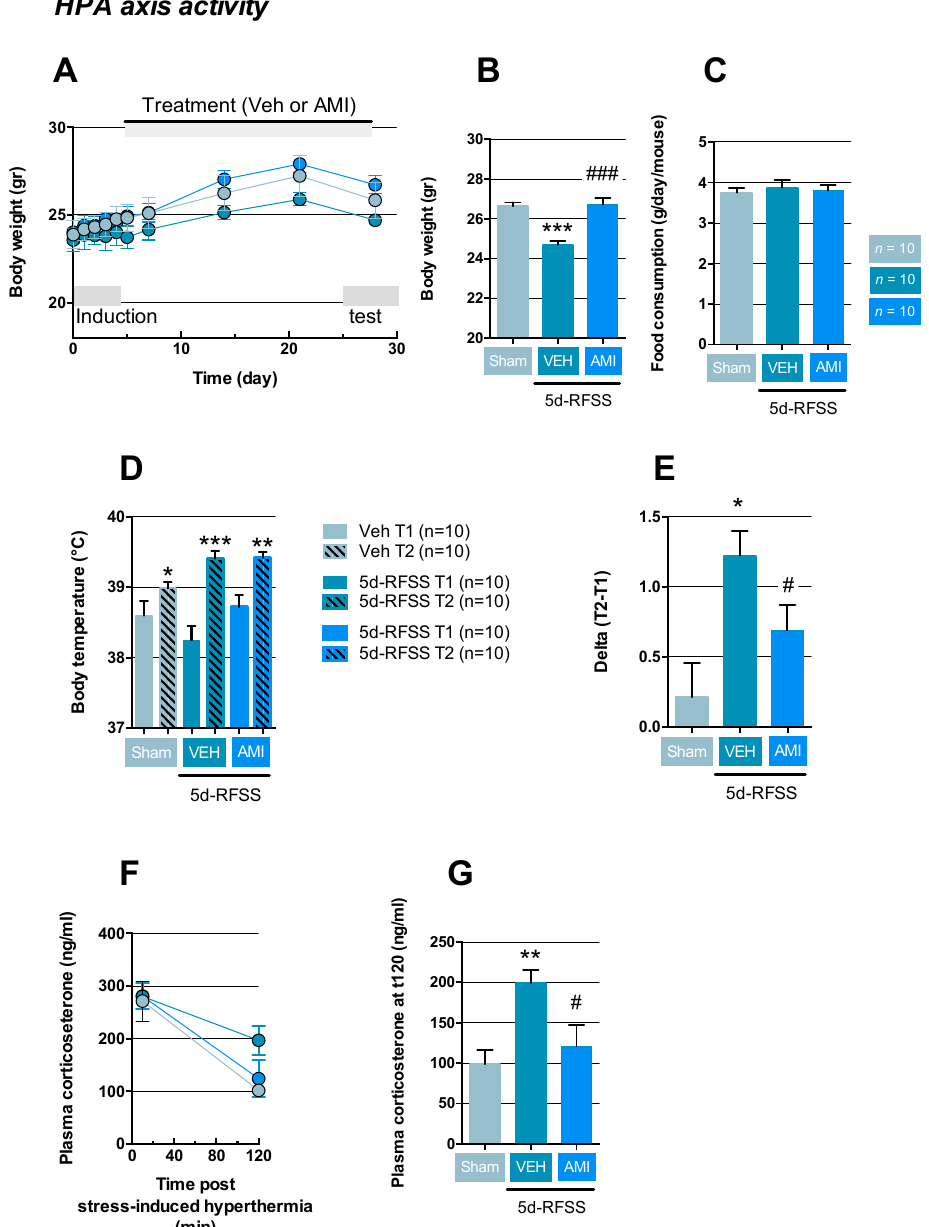
Figure 3. Impact of 5d-RFSS on HPA axis in C57BL/6J mice. ( A – C ) Body weight and food consumption. Data are means ± SEM of body weight (in g). Kinetic ( A , B ) body weight measured just before the test phase. One-way ANOVA showed a significant effect of treatment factor (F(2,27) = 20.6; p < 0.001). Data are means ± SEM of food consumption (C). One-way ANOVA did not show a significant effect of treatment factor (F(2,27) = 0.17; p = 0,83]. ( D , E ) Stress-induced hyperthermia. Data are means ± SEM of body temperature (in degrees Celsius) after the first (T1) and second (T2) measure ( D ). Two-way ANOVA with repeated measures did not show a significant effect of treatment (F(2,25) = 1.65; p = 0.21) but a significant effect of time (F(1,25) = 48.37; p = 0.02) and of the interaction between both factors (F(1,25) = 4.21; p < 0.001). Data are means ± SEM of the difference in temperature (in degrees Celsius) between the second and first measure (DelatT=T2-T1) ( E ). One-way ANOVA showed a significant effect of treatment factor (F(2,27) = 6.29; p = 0,006) ( F – G ) Plasma corticosterone levels. Data are means ± SEM of plasma corticosterone levels (in ng/mL) immediately after stress-induced hyperthermia and 120 min later ( F ). Data are means ± SEM of plasma corticosterone at t120 (in degrees Celsius) ( E ). One-way ANOVA showed a significant effect of treatment factor (F(2,27) = 6.34; p = 0.005). n = 10 mice per group. * p < 0.05, ** p < 0.01 and *** p < 0.001: significantly different from control non-stressed mice (sham). # p < 0.05 and ### p < 0.001: significantly different from 5d-RFSS mice using a Fischer’s PLSD post-hoc